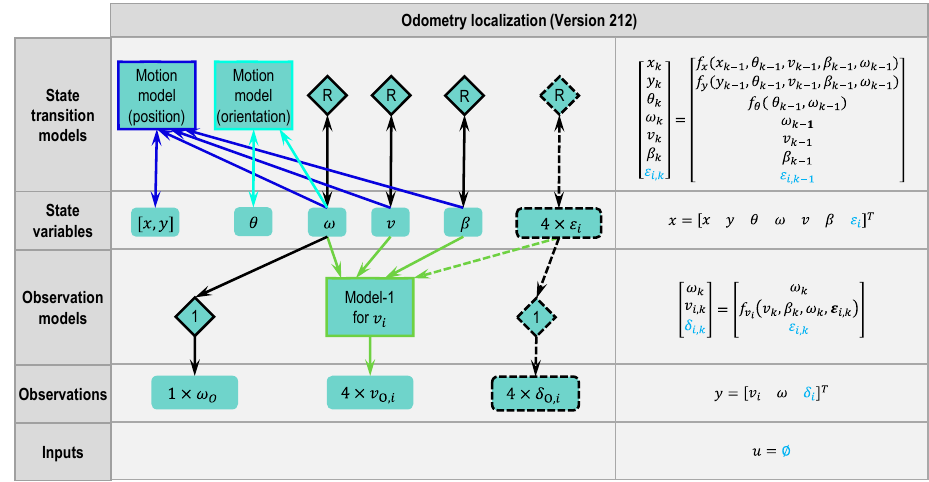
Figure 10. Modular approach to designing a state estimator for odometry localization (Version 212 based on Version 111, changes marked with dashed lines or dashed blocks and blue letters, respectively).